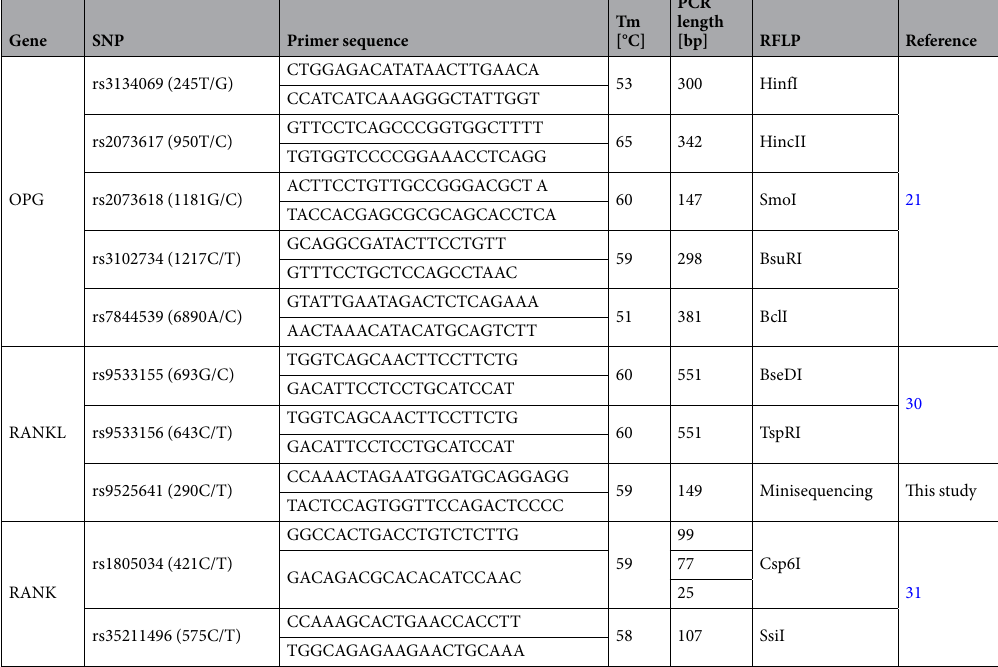
Table 2. Summary of primers and amplicons used for SNPs